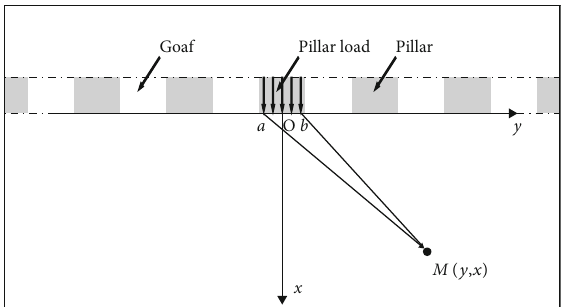
Figure 5: A model of half-plane body subjected to distributed force on the